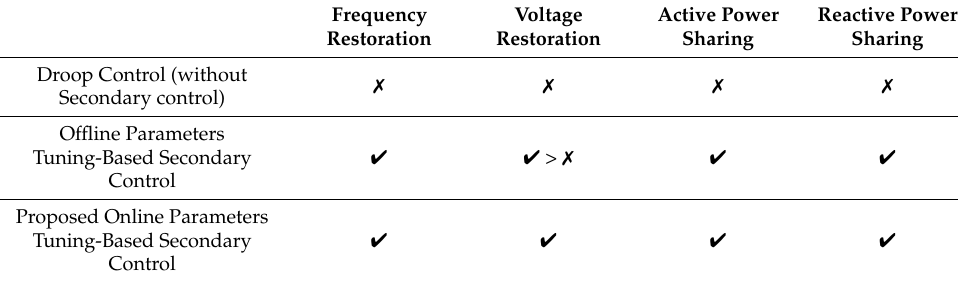
Table 4. Traditional droop control vs. proposed